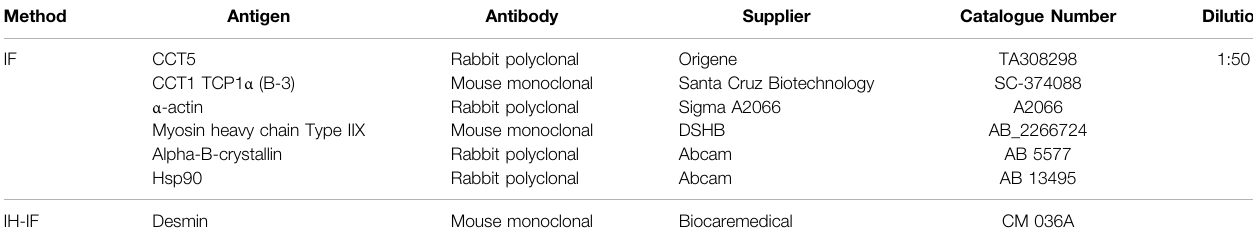
TABLE 1 | Primary antibodies used for immunohistochemistry (IH), and immuno fl uorescence and double immuno fl uorescence (IF).